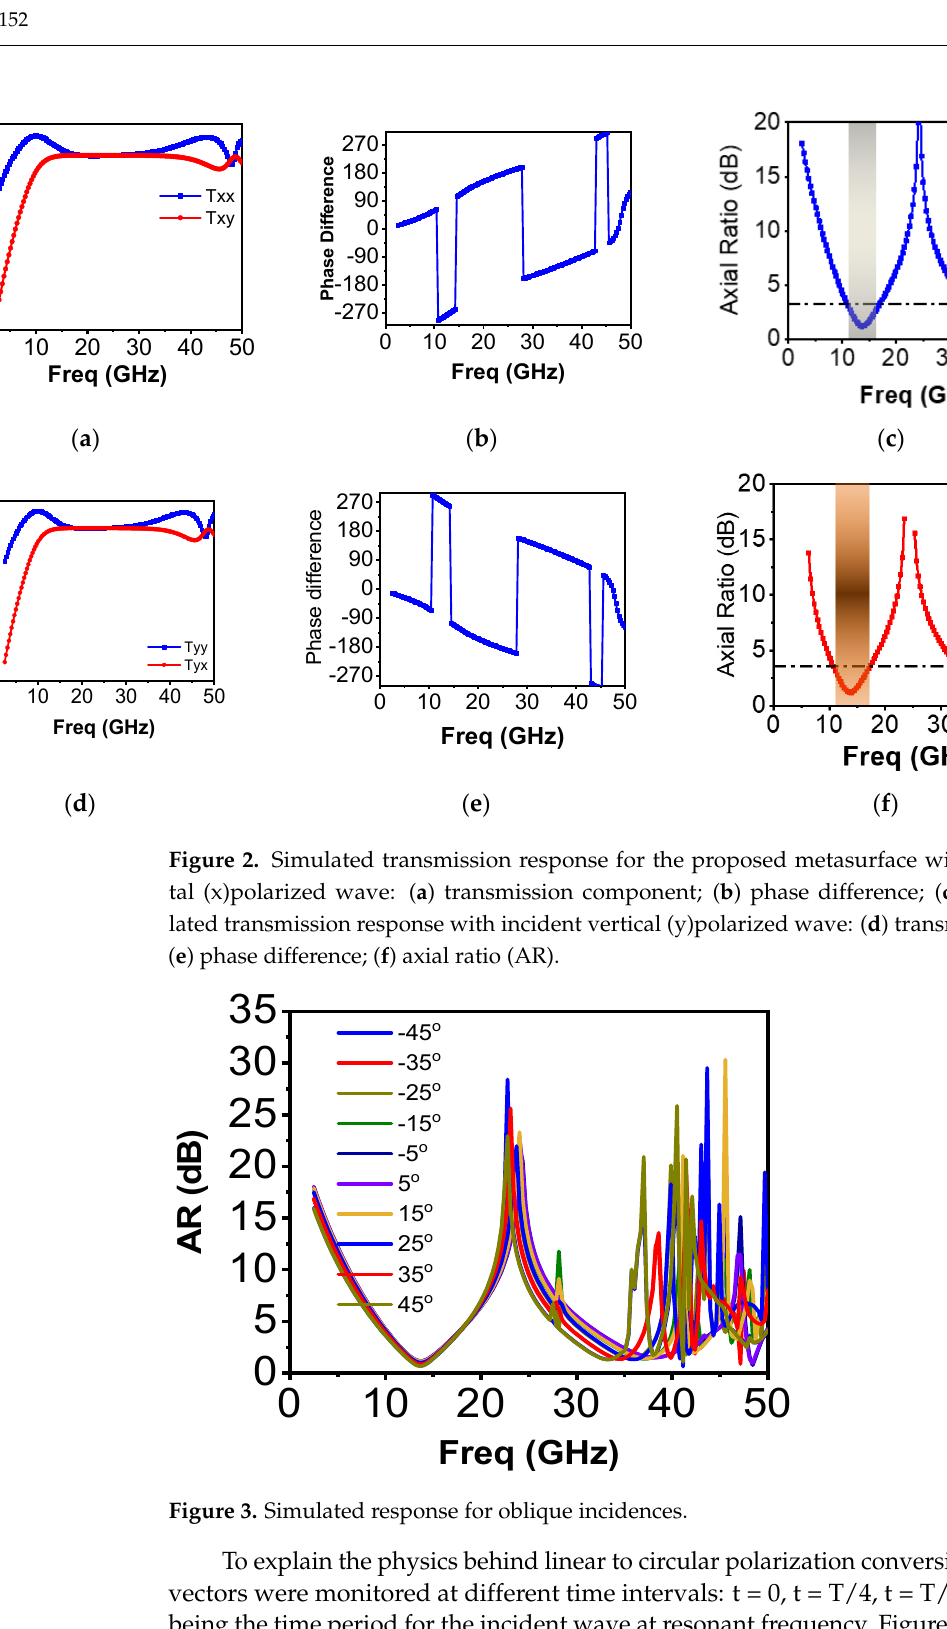
Figure 3. Simulated response for oblique incidences. To explain the physics behind linear to circular polarization conversion, surface cur- rent vectors were monitored at different time intervals: t = 0, t = T/4, t = T/2, t = 3T/4, with T being the time period for the incident wave at resonant frequency. Figure 4a–d show surface current vectors at 13.58 GHz, whereas Figure 4e–h show surface current vectors